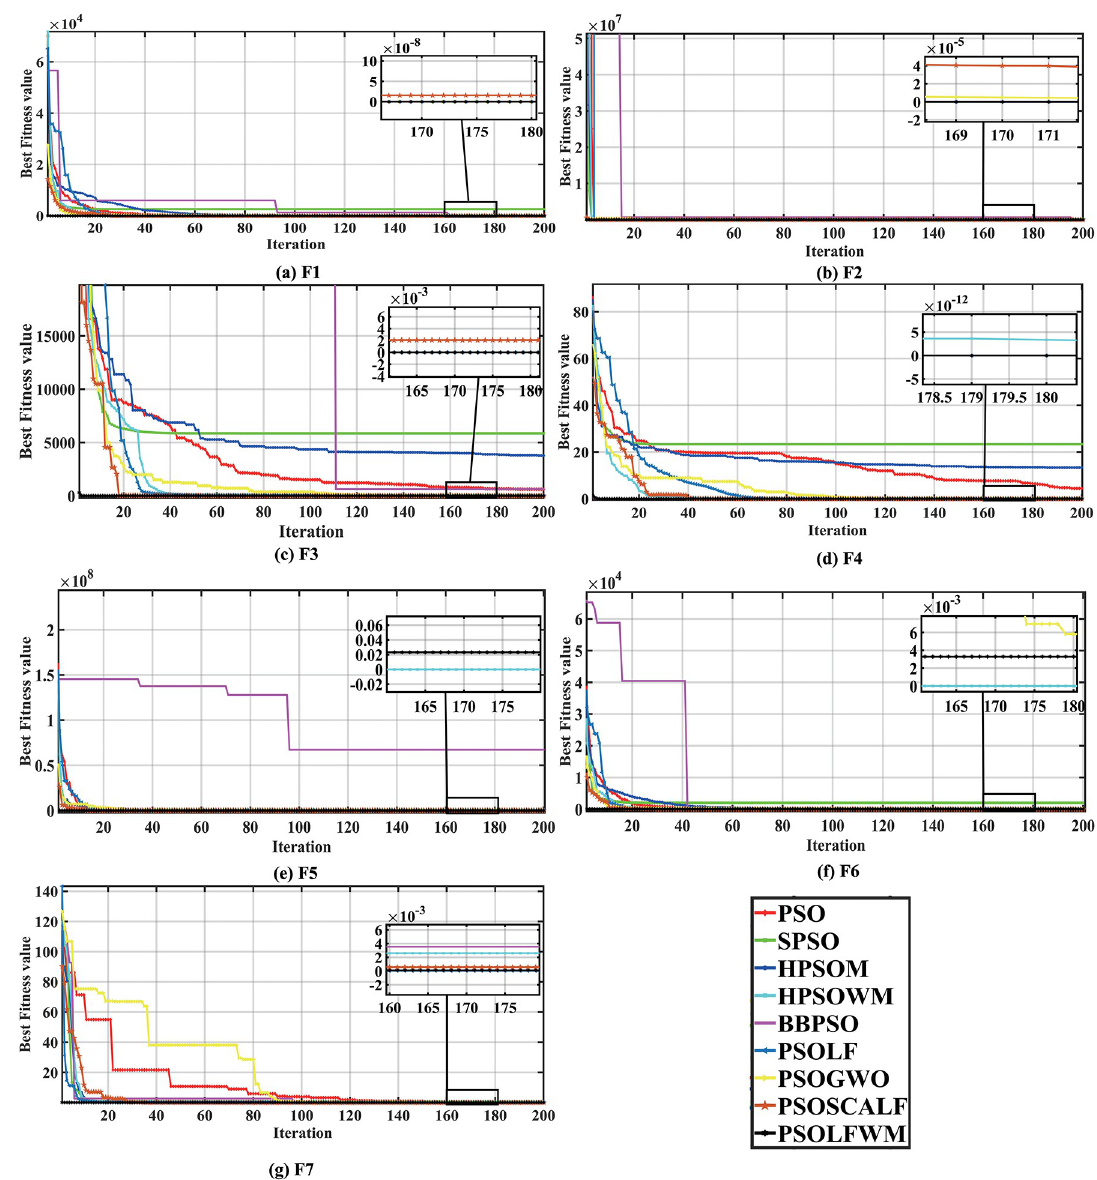
Fig 1. Convergence curve of unimodal functions compared with the PSO family algorithms. (a) F1, (b) F2, (c) F3, (d) F4, (e) F5, (f) F6, and (g) F7.